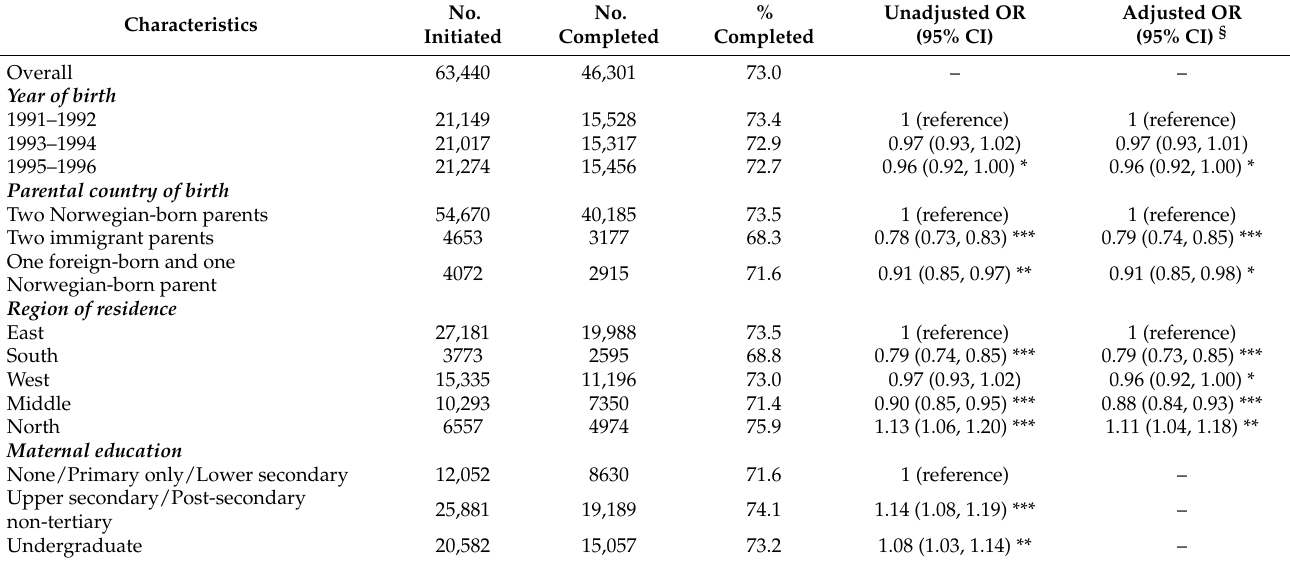
§ Estimates adjusted for all variables in the tables ( N = 201,326) except for maternal education level and maternal occupation which were not included due to a high proportion of missing values. # Others refers to clerical support workers, service and sales workers, skilled agricultural, forestry and fishery workers, craft and related trades workers, plant and machine operators and assemblers and elementary occupations. ** p < 0.01; *** p < 0.0001. Abbreviations: HR: hazard ratios; CI: confidence interval. Table 4. Sociodemographic characteristics of HPV vaccination completion among women who initiated catch-up HPV vaccination from November 2016 to June 2018 in Norway.